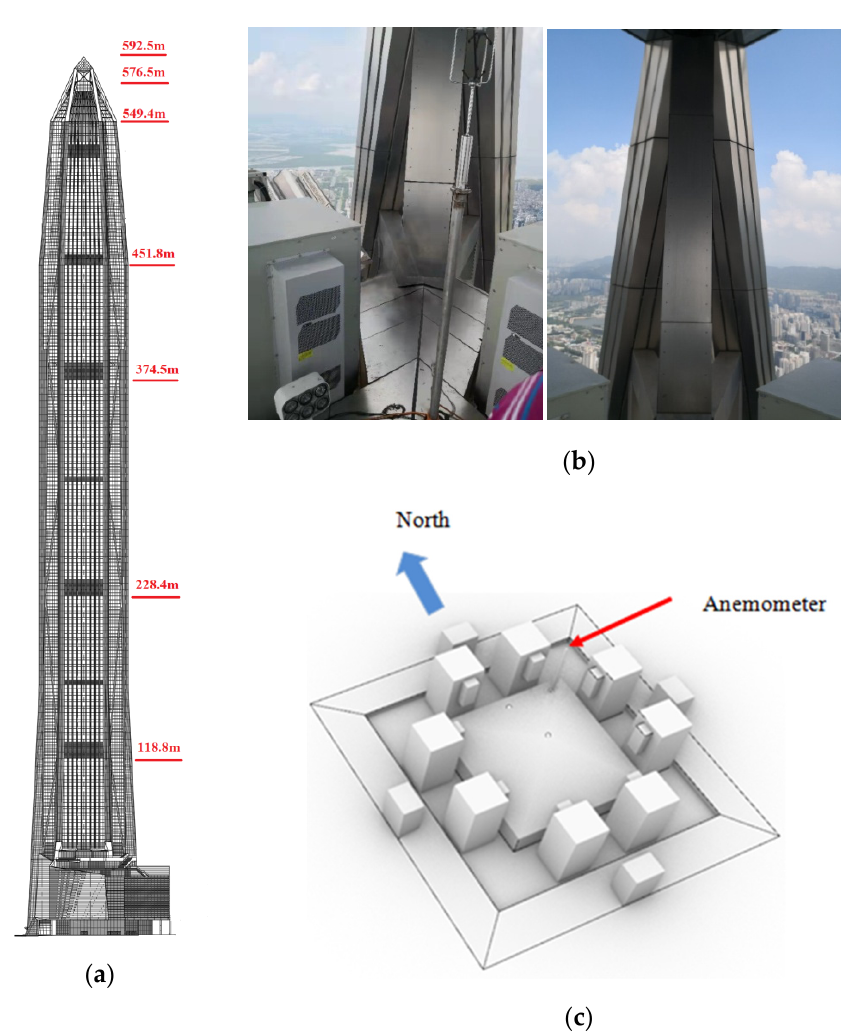
Figure 1. Landscape around NLDI.